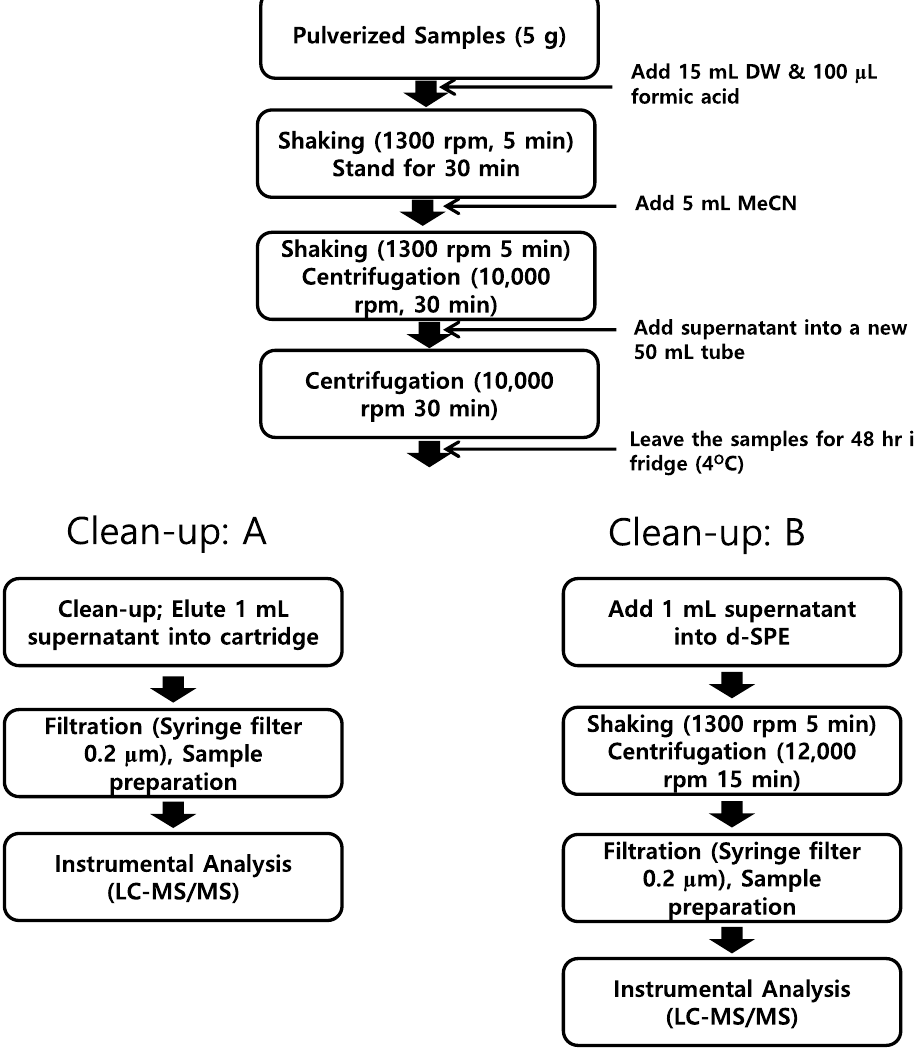
Figure 1. The flow chart for sample preparation for the analysis.